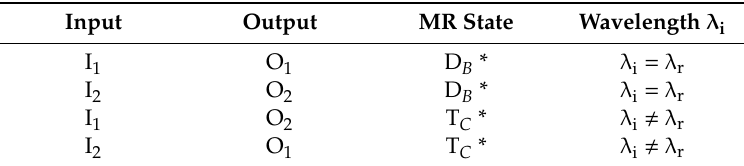
Table 1. MR based 2 × 2 OSE switching state